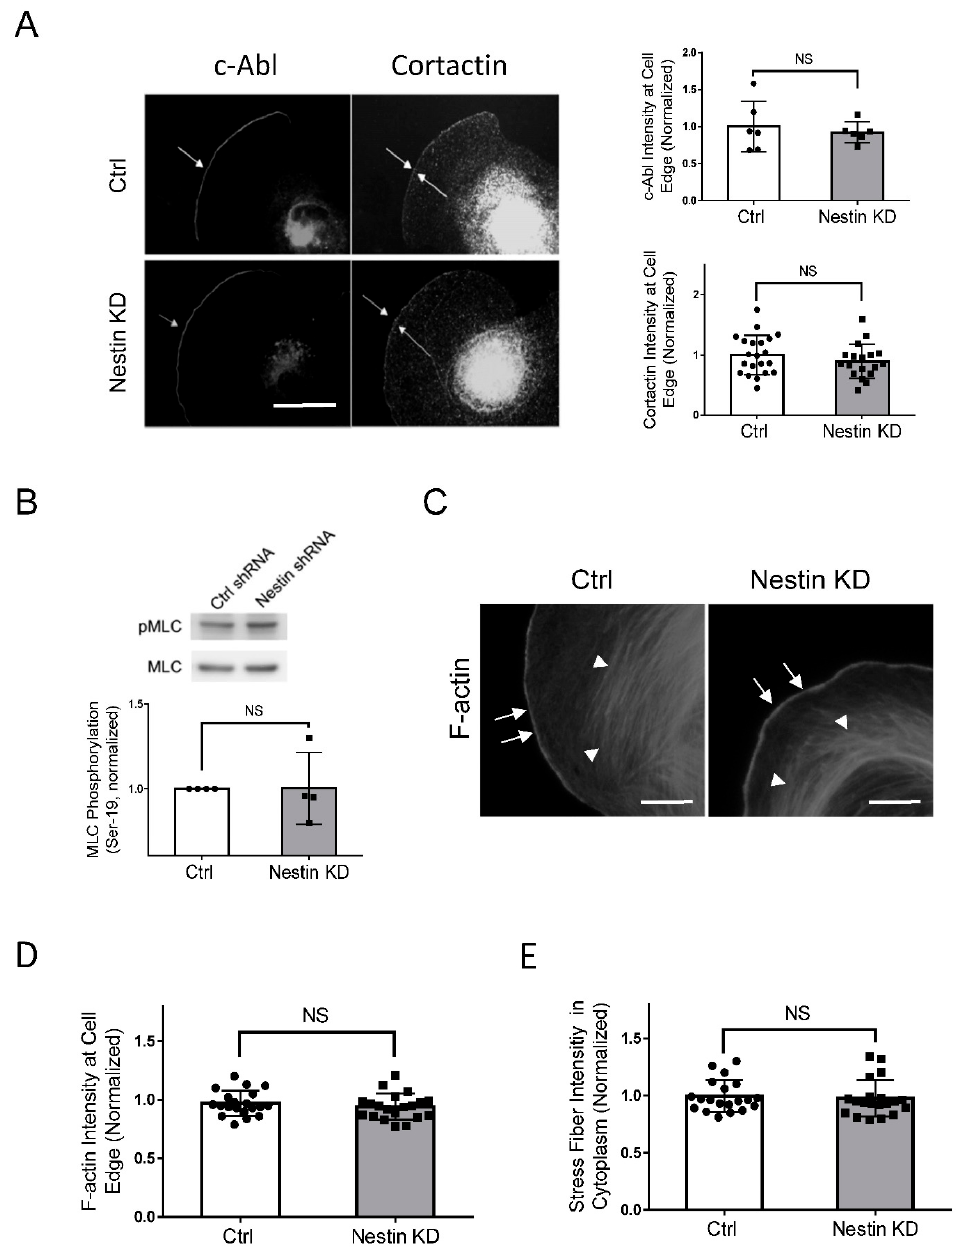
Figure 6. Nestin KD does not affect the recruitment of c-Abl and cortactin, myosin phosphorylation, and F-actin. ( A ) Ctrl and nestin KD human ASM cells were plated on collagen-coated coverslips for 45 min and immunostained for c-Abl and cortactin, Scale bar: 10 μ m. The arrows point to the cell edge. The relative intensity of c-Abl and cortactin was calculated using the following formula: intensity of each cell/average intensity of control cells. Data are mean values of at least 20 cells from three experiments. Error bars indicate SE. NS, not significant. ( B ) Myosin light chain phosphorylation at Ser-19 of Ctrl and nestin KD human ASM cells was evaluated by immunoblot analysis. The phosphorylation levels of nestin KD cells are normalized to Ctrl cells. Data are mean values of 4 batches of cell cultures. Error bars indicate SE. ( C – E ) Ctrl and nestin KD human ASM cells were plated on collagen-coated coverslips for 45 min and stained with phalloidin for F-actin. Scale bar: 10 µ m. The arrows point to the cell edge. The arrow heads point to stress fibers. Data are mean values of 4 batches of cell cultures. Error bars indicate SE. NS, not